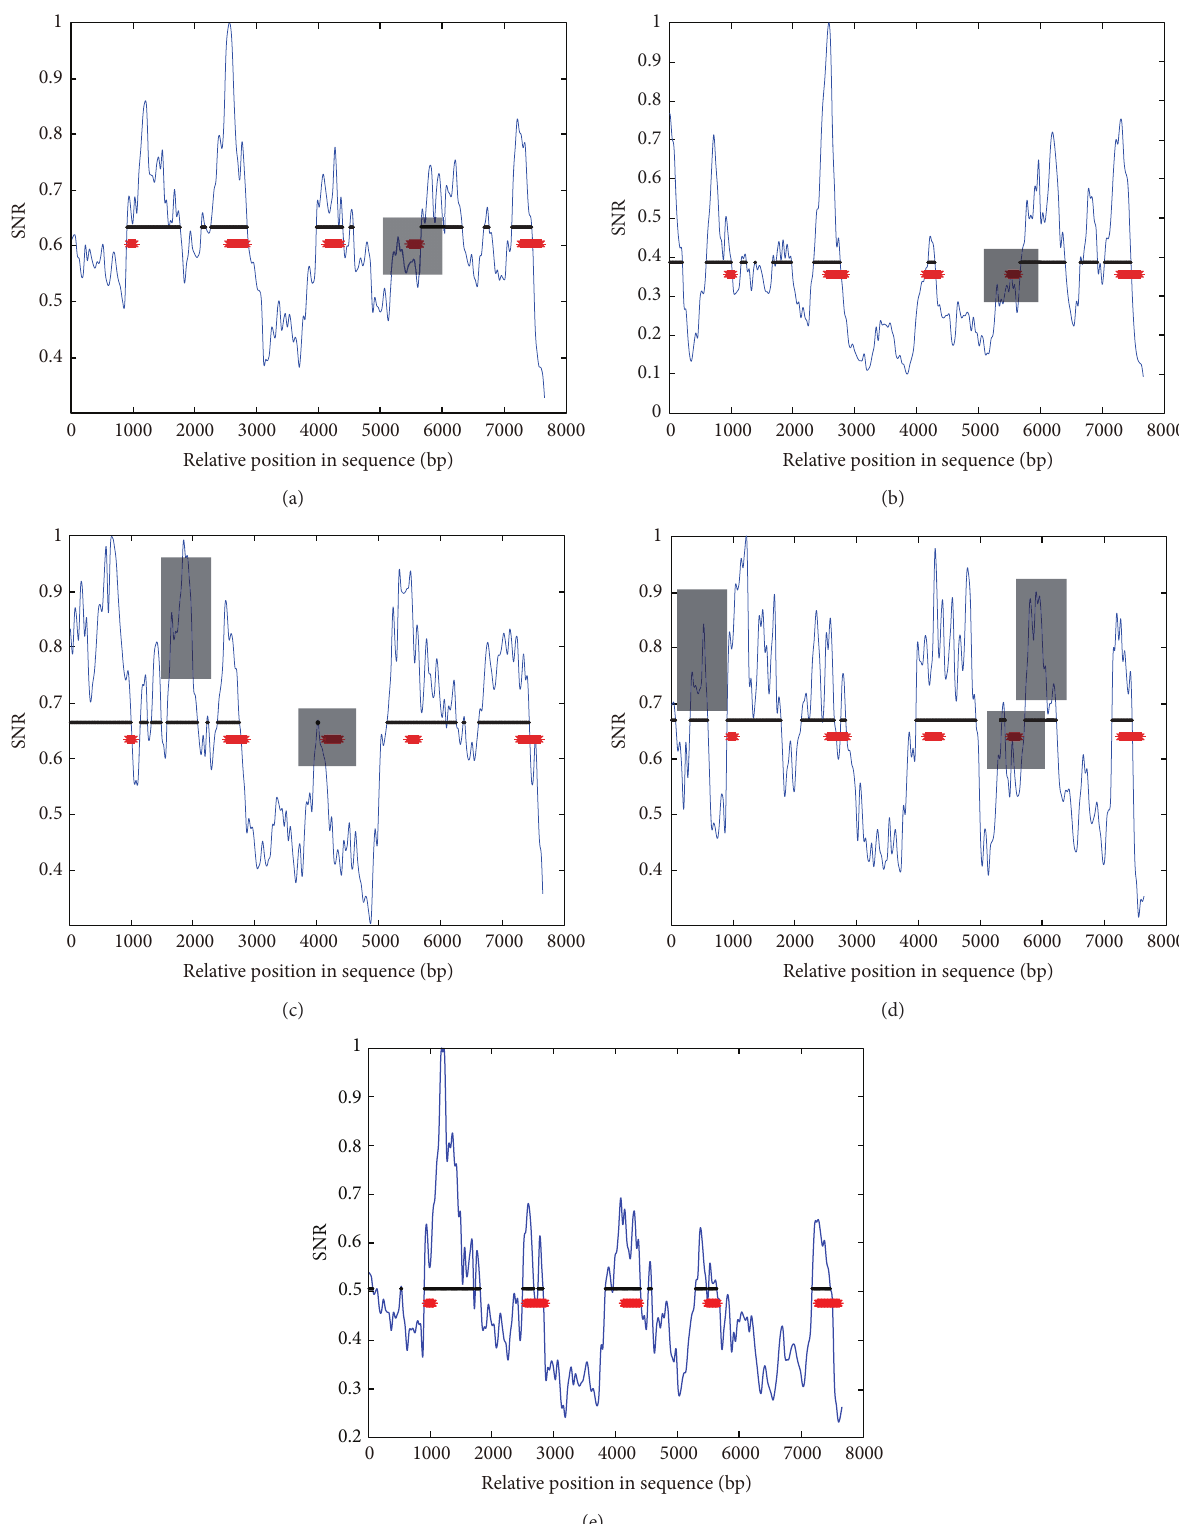
Figure 7: Exonic identification results of gene sequence F56F11.4 using five mapping methods and the proposed algorithm. (a) Voss method, (b) EIIP method, (c) SP method, (d) PN method, and (e) Code13 method. The red bold line segments represent the true exons that must be identified, the black thin line segments represent the predicted candidate exons, and the vertical heights of those line segments represent their optimal thresholds. The square shadow represents the missing true exon; the rectangle shadow represents the false predicted